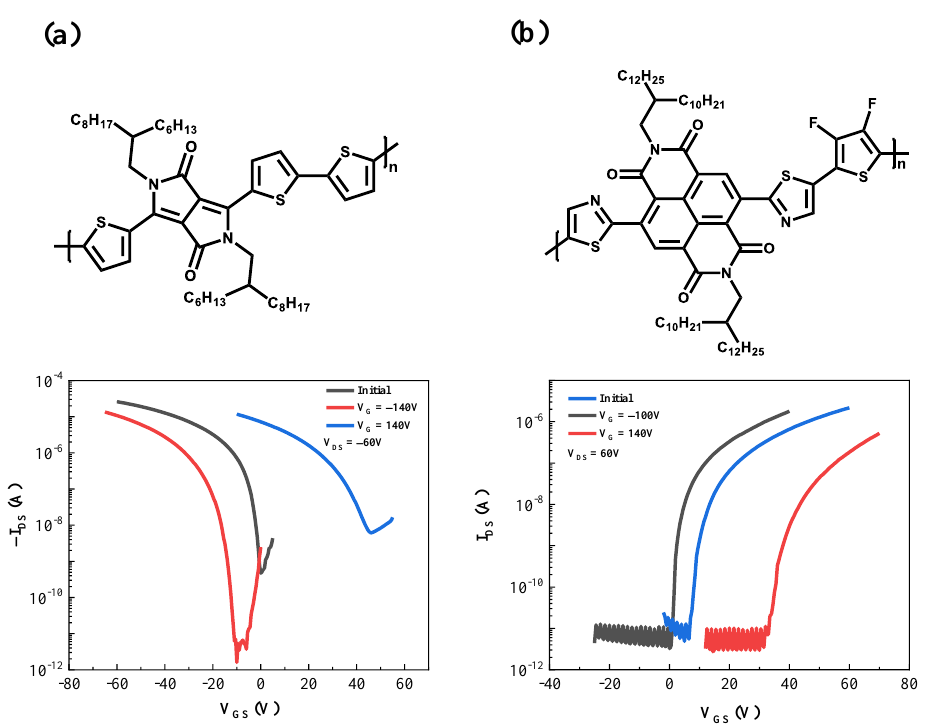
Figure 5. Chemical structures and transfer curves at different pre-applied gate voltages for ( a ) PDPP3T and ( b ) PTzNDI-2FT OFET.